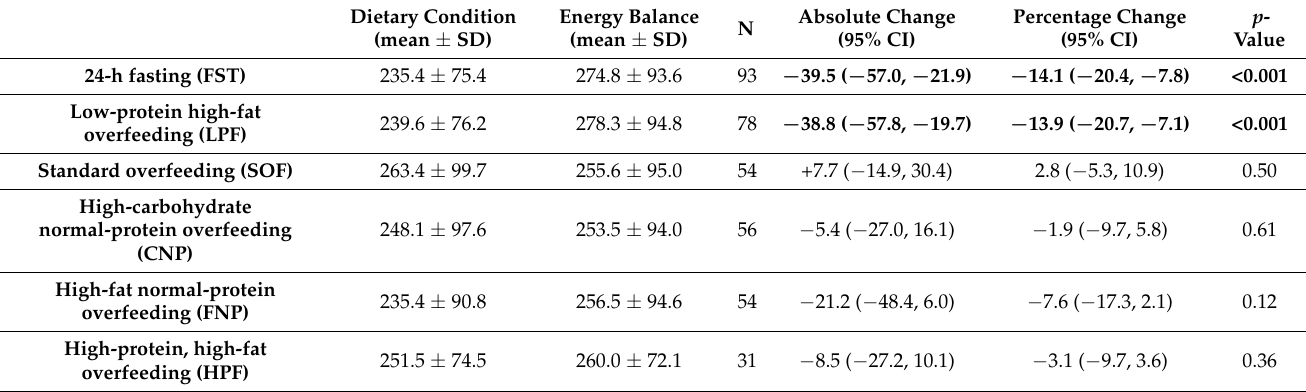
Table 2. Urinary dopamine excretion rates during 24-h fasting and different overfeeding